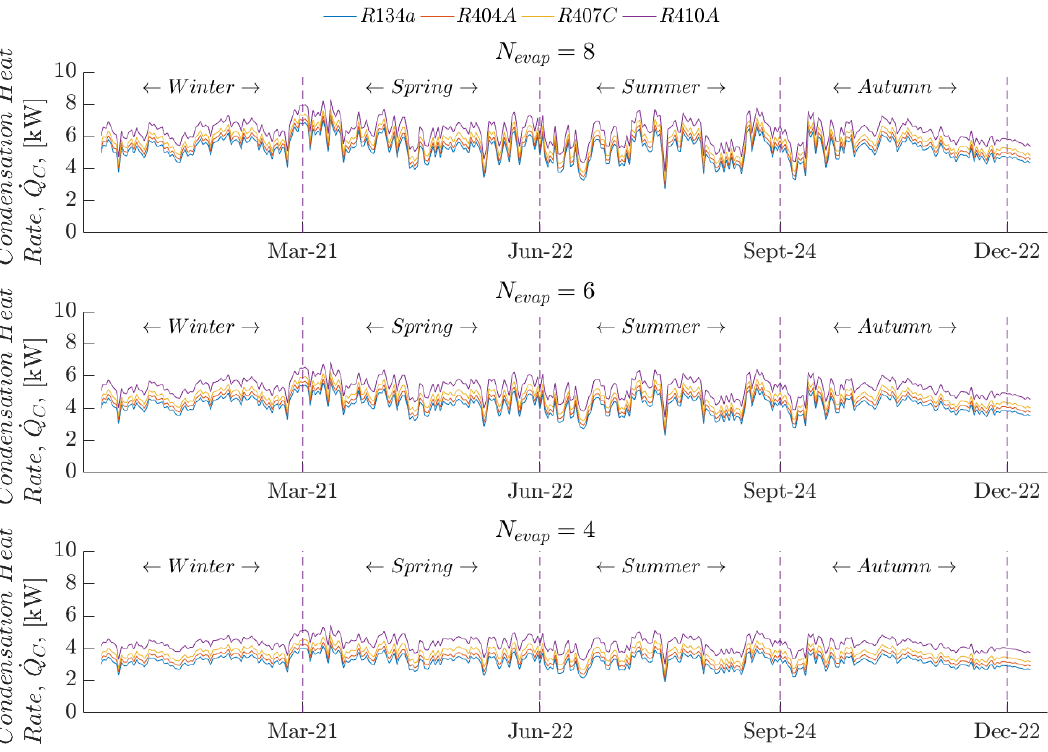
Figure 13. Condensation heat flow throughout the year for all refrigerants using 4, 6 and 8 flat-plate solar solar collectors.